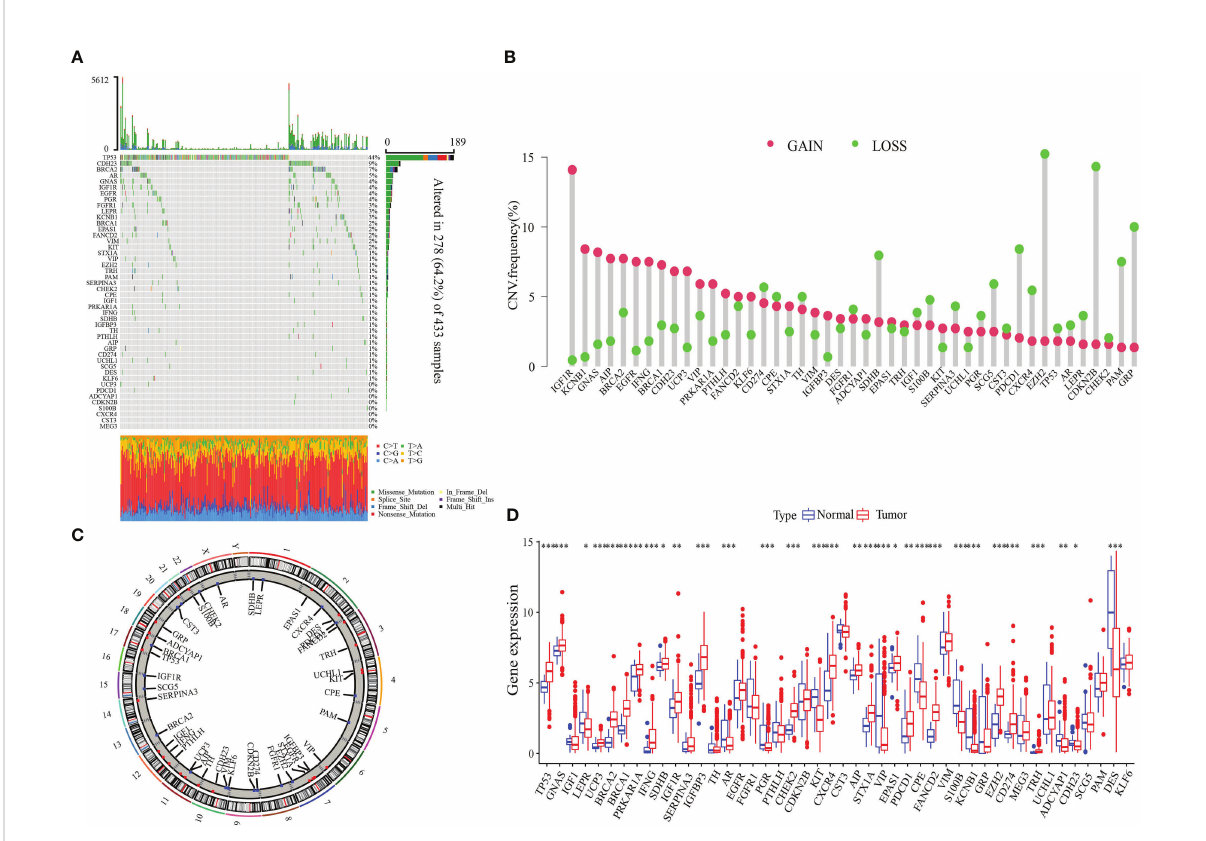
FIGURE 3 Landscape of genetic and expression variation of NMNGs in STAD. (A) 278 of 433 samples have genetic alterations of 46 NMNGs. (B) CNV mutation frequency of NMNGs. (C) Position of CNV change of NMNGs on human chromosome. (D) Difference in the expression level of 46 NMNGs between normal and tumor samples. *P<0.05, **P<0.01,